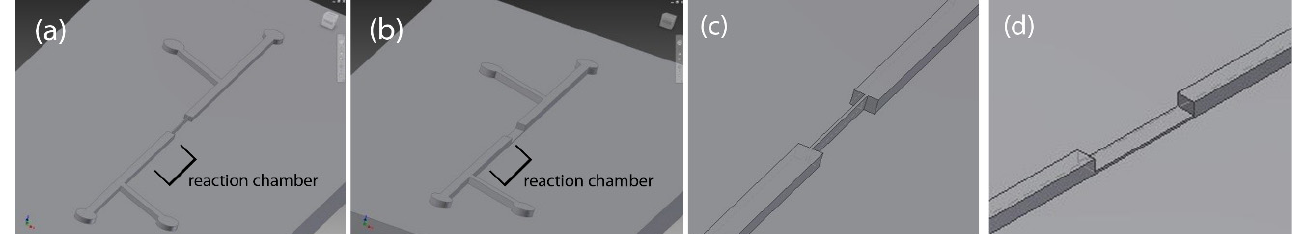
Figure 2. Different microfluidic chip designs in Inventor Professional 2012. ( a ) Constriction in width (60 µm). ( b ) Constriction in height (60 µm). Magnification of ( c ) the constriction in width (60 µm), and ( d ) constriction in height (60 µm).